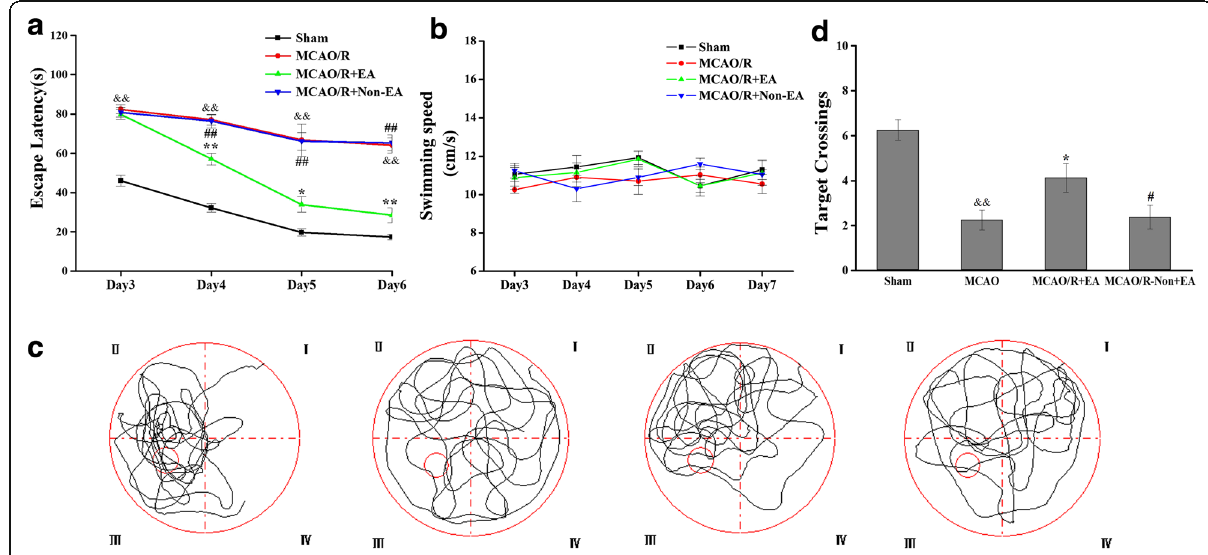
Fig. 2 Evaluation of spatial reference learning and memory by Morris Water Maze test. a , b Mean escape latency time and swimming speed during the orientation navigation test on Days 3 – 6 after EA treatment. c , d Times the rats crossed over platform location and representative path diagrams on Day 7 after EA treatment during the spatial memory test in different groups. ( n = 12 each group; && p < 0.01, the MCAO/R group versus the Sham group; ** P < 0.01, * P < 0.05, the MCAO/R + EA group versus the MCAO/group; ## P < 0.01, # P < 0.05, the MCAO/R+ Non- EA group versus the MCAO/R + EA